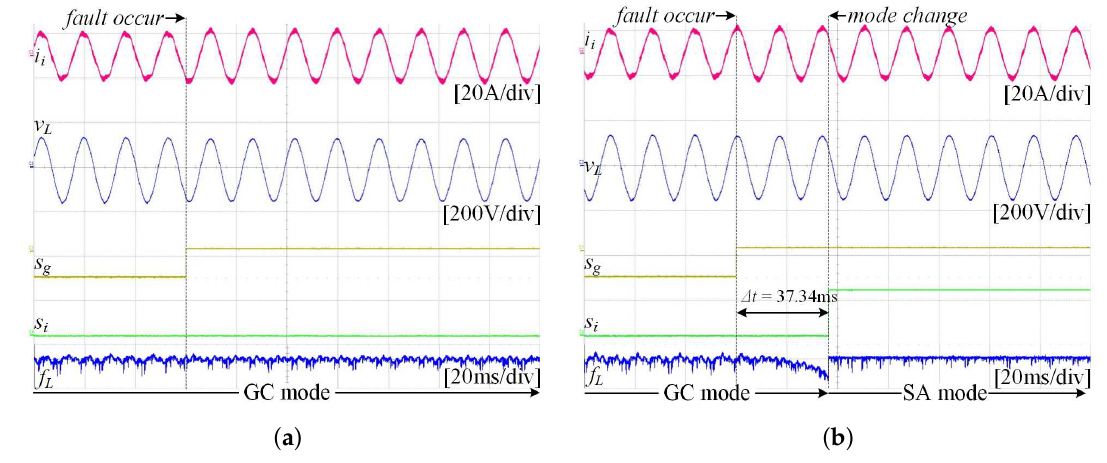
Figure 16. Experimental results ( a ) without NDZ ( b ) with NDZ detection